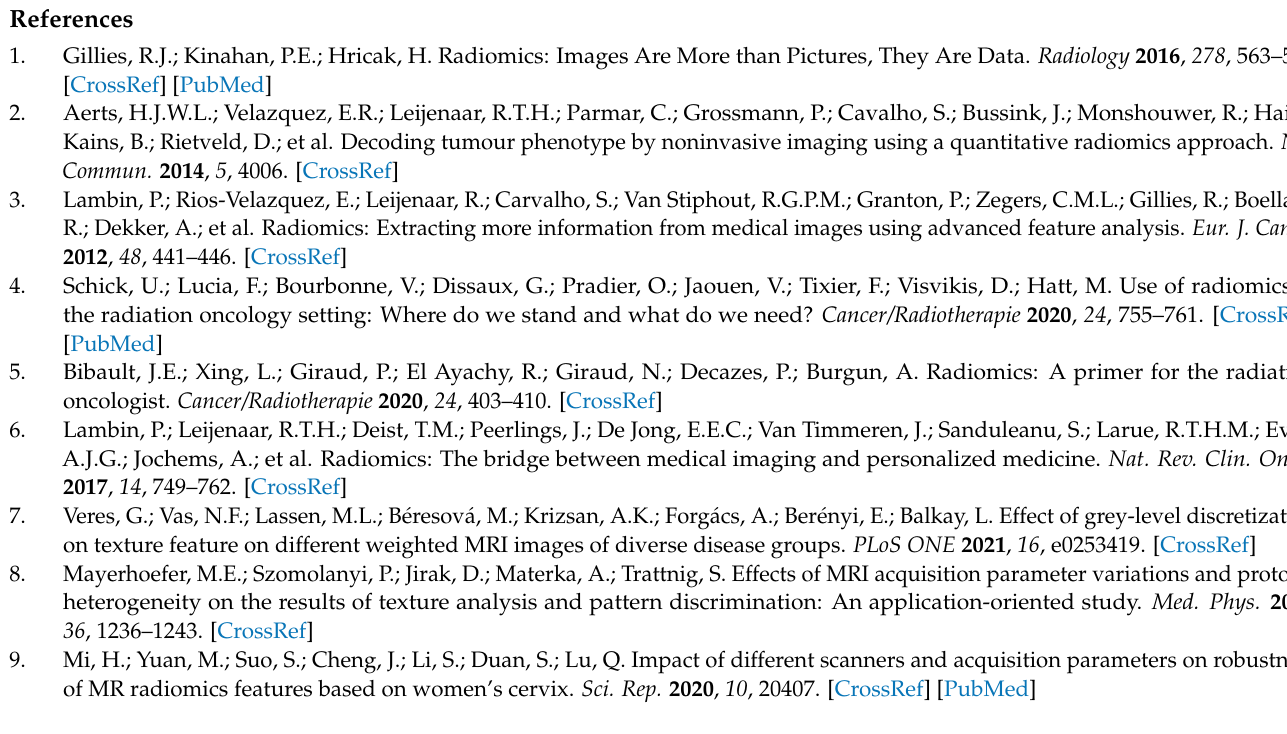
Texture Indices; Figure S1: Coefficient of Variation for all non-normalized Texture Indices and for every phantom; Figure S2: Coefficient of Variation for all normalized Texture Indices and for every phantom; Figure S3: Coefficient of Variation for the selected normalized Texture Indices; Figure S4: Relative Parameter Difference for the selected normalized Texture Indices; Figure S5: Interclass Correlation Coefficient for all normalized Texture Indices; Figure S6: Relative Parameter Difference with different acquisition setups for every fantom; Photo S1: Placement of biological